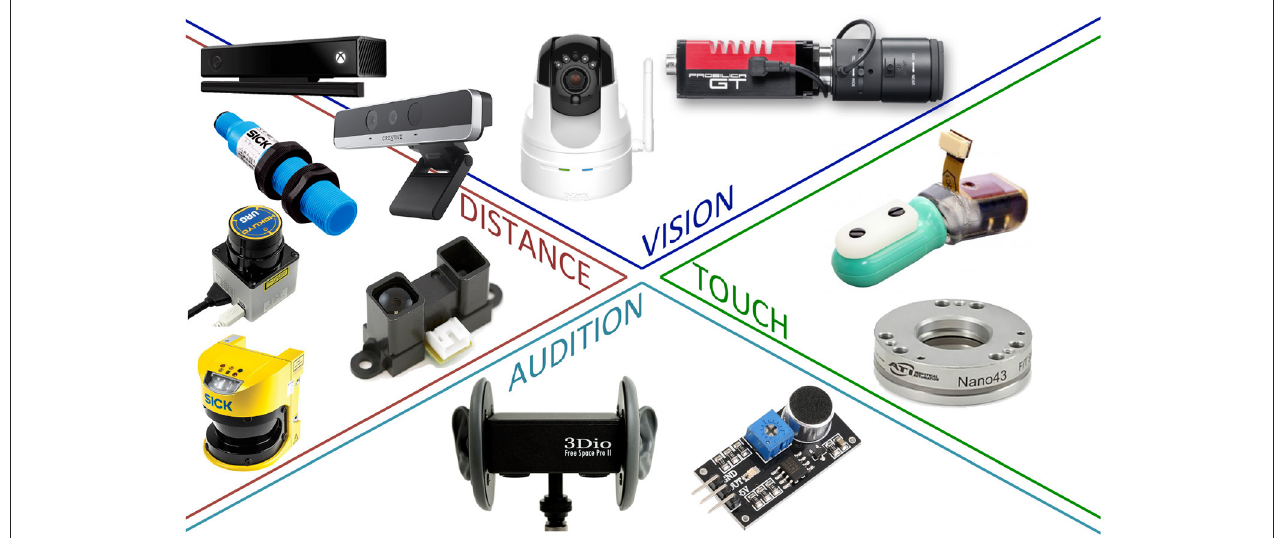
FIGURE 1 | Examples of artificial sensors. Clockwise from the top left: Microsoft Kinect ® and Intel Realsense ® (vision and distance), Sony D-Link DCS-5222L ® and AVT GT ® (vision), Syntouch BioTac ® and ATI Nano 43 ® (touch), sound sensor LM393 ® and 3Dio Free Space Pro II ® Binaural Microphone (audition), proximity sensor Sharp GP2Y0A02YK0F ® , Laser SICK ® , Hokuyo URG ® , and proximity sensor SICK CM18-08BPP-KC1 ® (distance). Note that Intel Realsense ® and Microsoft Kinect ® provide both the senses of vision and of